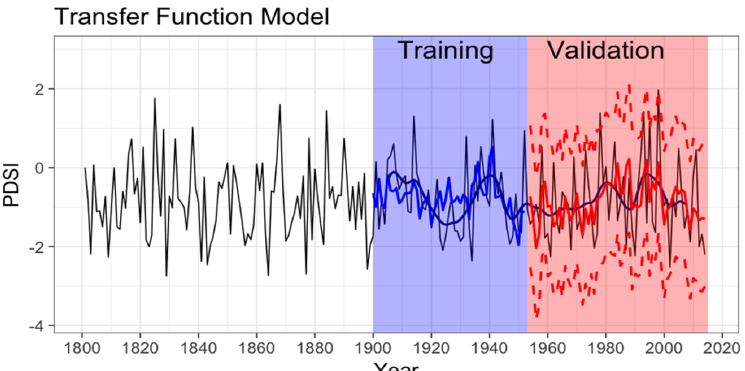
Figure 11. Observed PDSI time series (black line) with the training dataset to build the model (blue line) for the period 1900–1953, including the filtered observed values (navy blue). Also comparison between the observed values (black line) and predicted values with the TF model for the validation period (1954–2014) (red line), including the corresponding 95% confidence intervals (red dash).